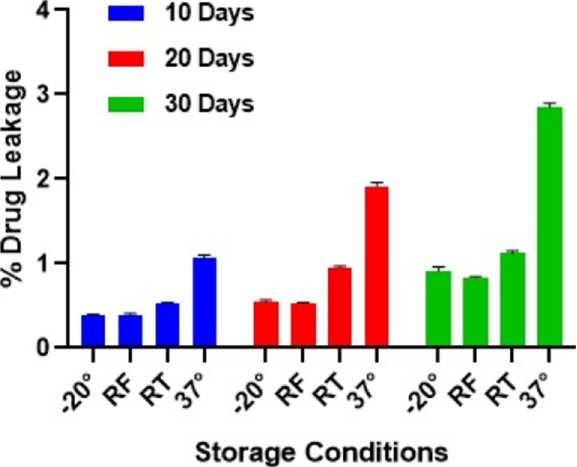
Fig 5. Extent of drug leakage from CL13 liposomes at different storage conditions.